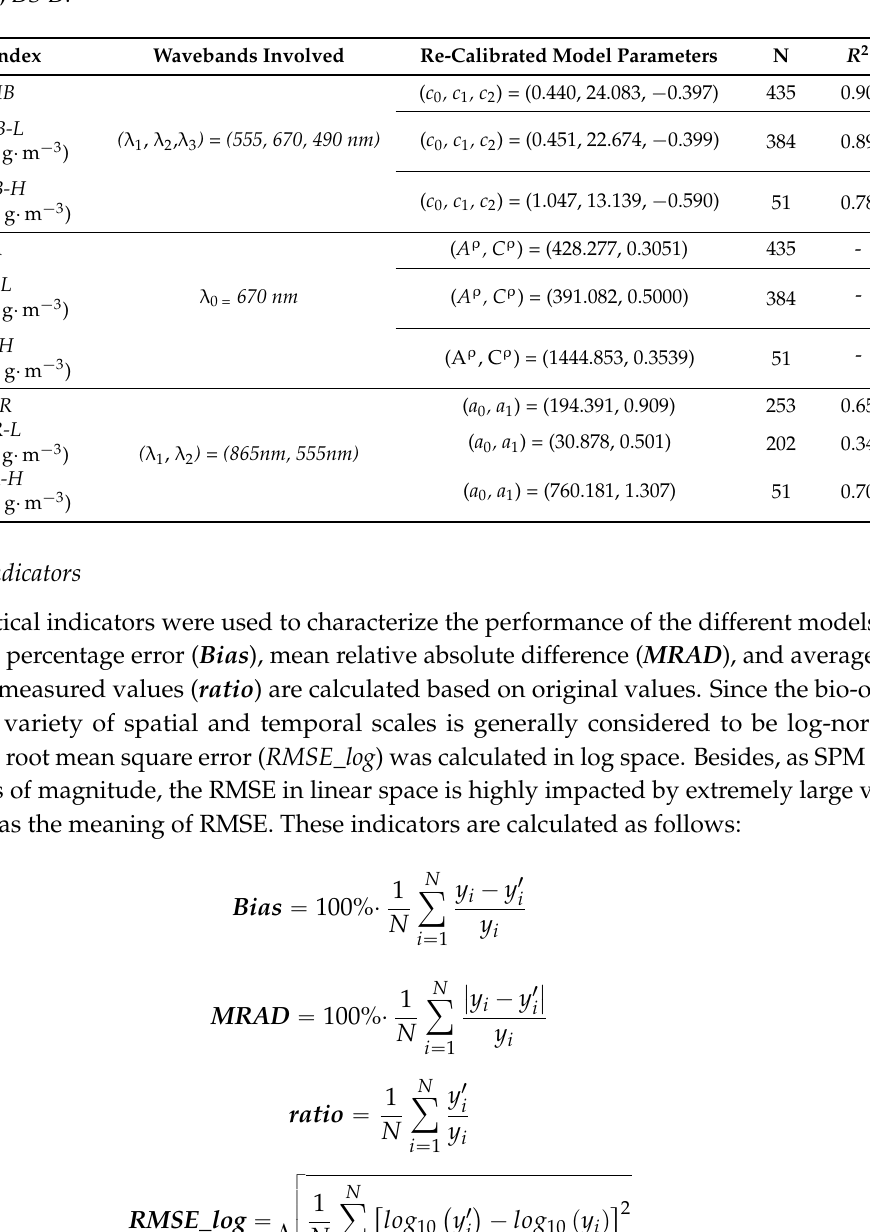
Table 3. Values of the parameters involved in the different models calibrated on the development sub-data set,